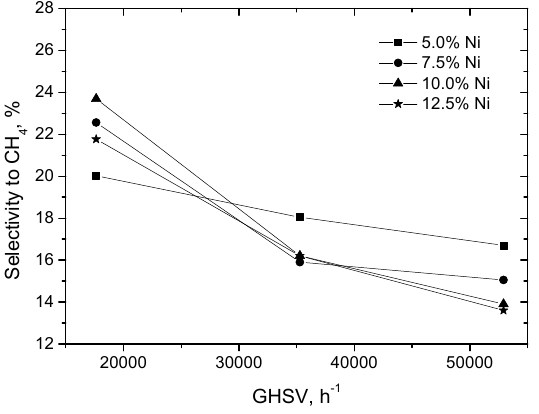
Figure 12. Effect of GHSV on selectivity to CH 4 for catalysts with different nickel loading at 400 °C.